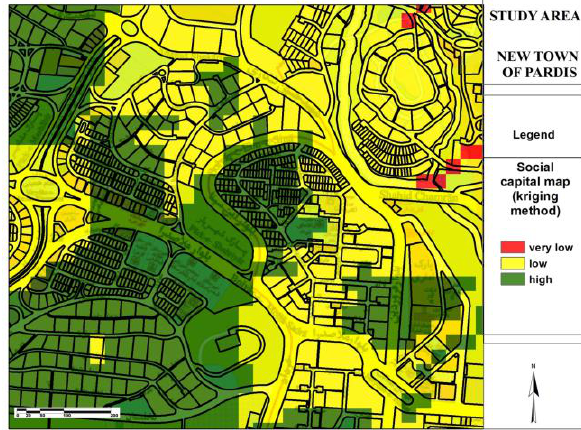
Fig. 4. Map of social capital of Pardis’ residents